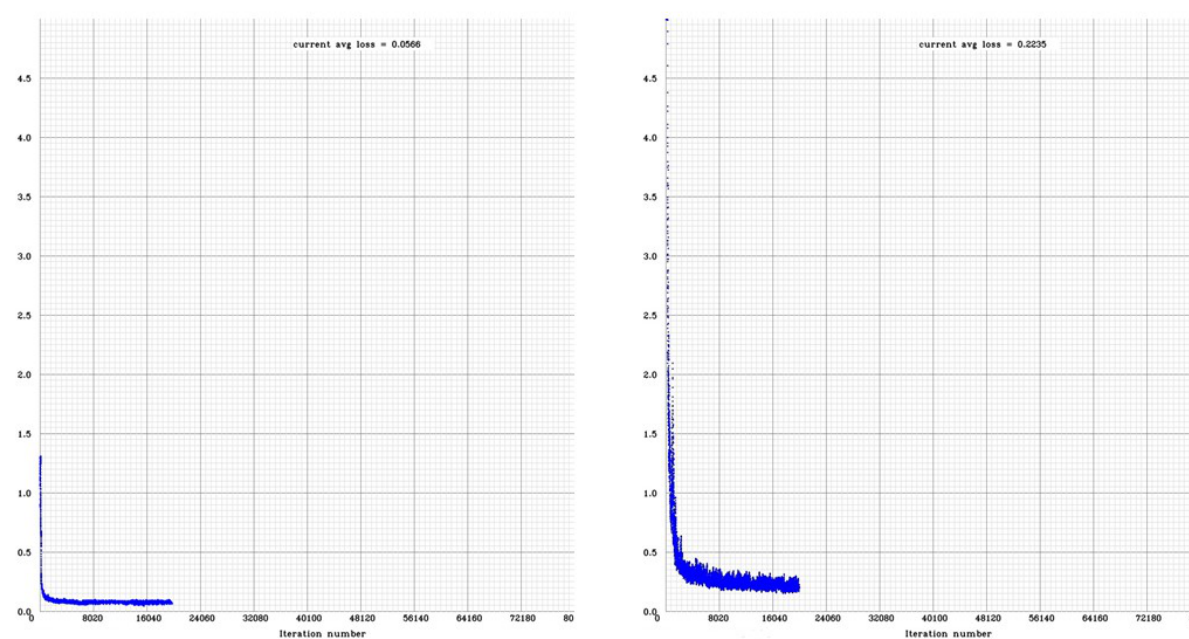
Figure 1 : Left: The evolution of the average loss related to the number of iterations, for the images with resolution (1024 × 1024). Right: The evolution of the average loss related to the number of iterations, for the images with resolution (256 × 256)